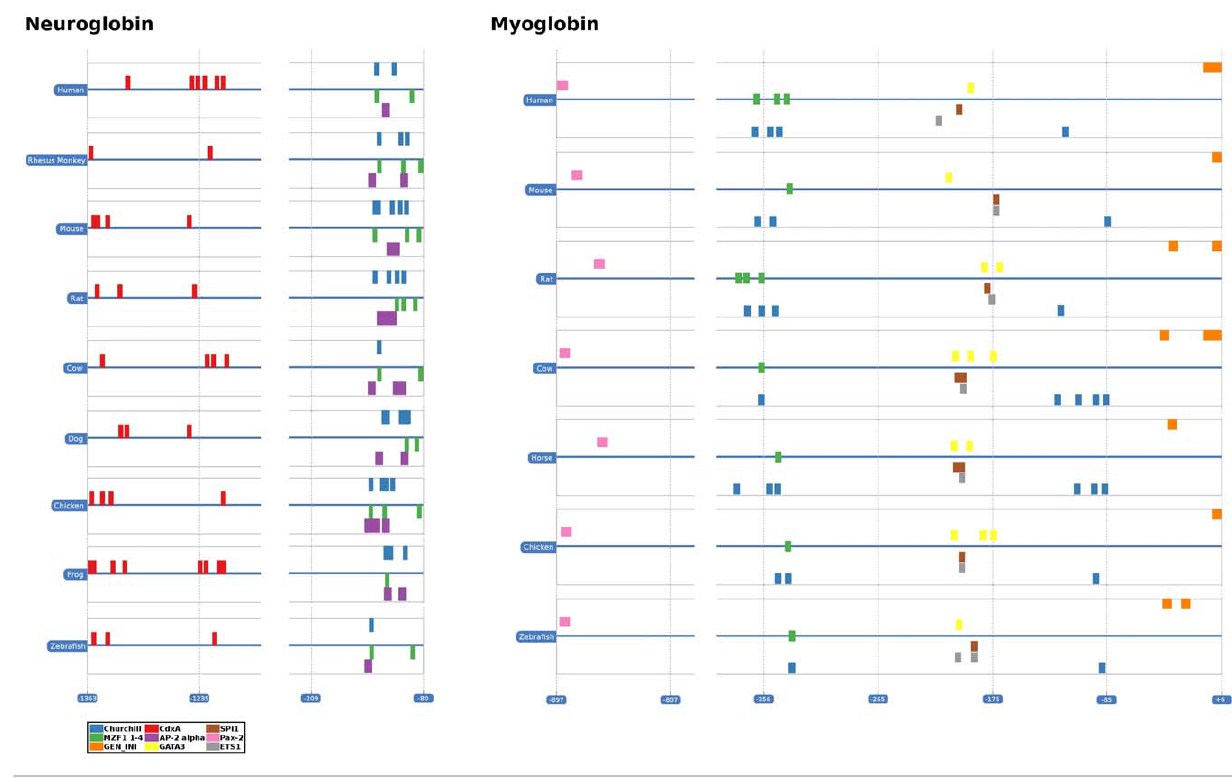
Figure 7. Graphical overview of the results from the CONREAL search. The TFBSs are represented as blocks with different colors. The blue lines indicate the genomic sequence. The scale on the x-axis describes the position of the motifs relative to the translation initiation site. The predicted TFBSs are positionally conserved among the different analyzed vertebrates.